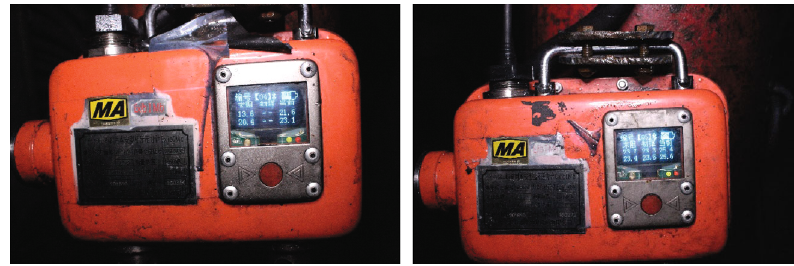
Figure 5: Hydraulic support working resistance monitoring